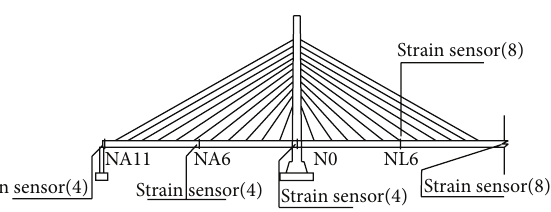
Figure 8: Stress and fatigue monitoring points on the box girder.